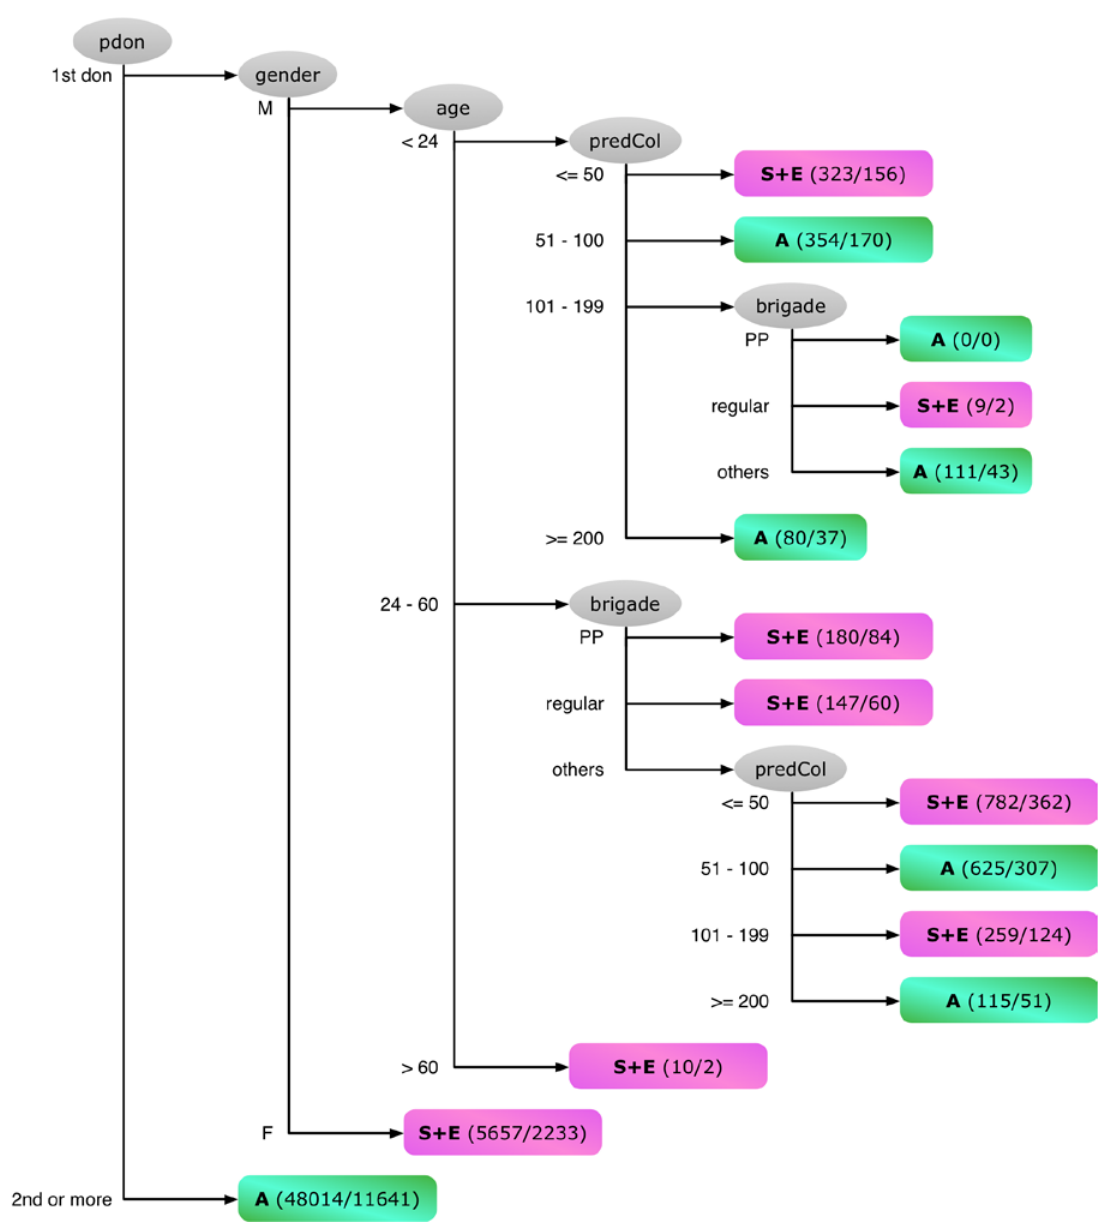
Figure 7: A perspective of the decision tree obtained about the influence of first time donations and